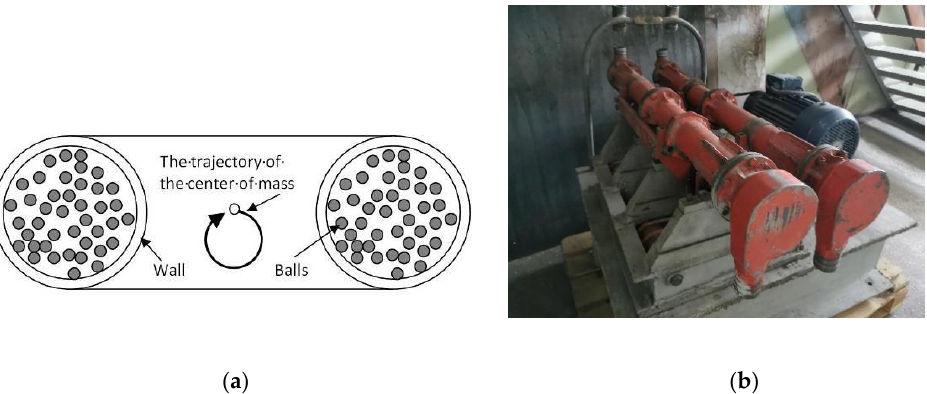
Figure 6. A vibrocentrifugal mill: ( a ) schematic cross-sectional view; ( b ) an example of the real-world